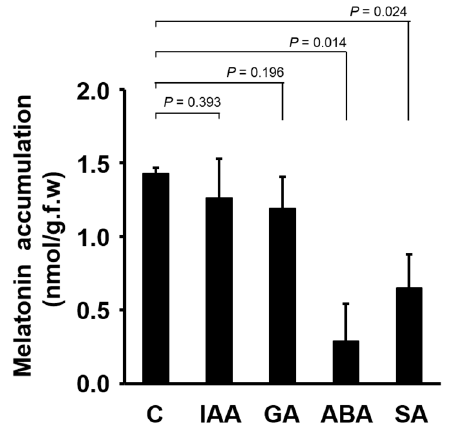
Figure 2. Influence of plant hormones on melatonin accumulation in maize leaves. The concentration of each hormone was 10 μ M and that of melatonin was 4 mM. Melatonin accumulation was measured after 12 h. Data represent the mean ± SD of three biological replicates. Each measurement was carried out with five seedlings. Statistical significance was examined by Student’s t -test. Abbreviations: C, control; IAA, indole-3-acetic acid; GA, GA 3 ; ABA, abscisic acid; SA, salicylic acid.